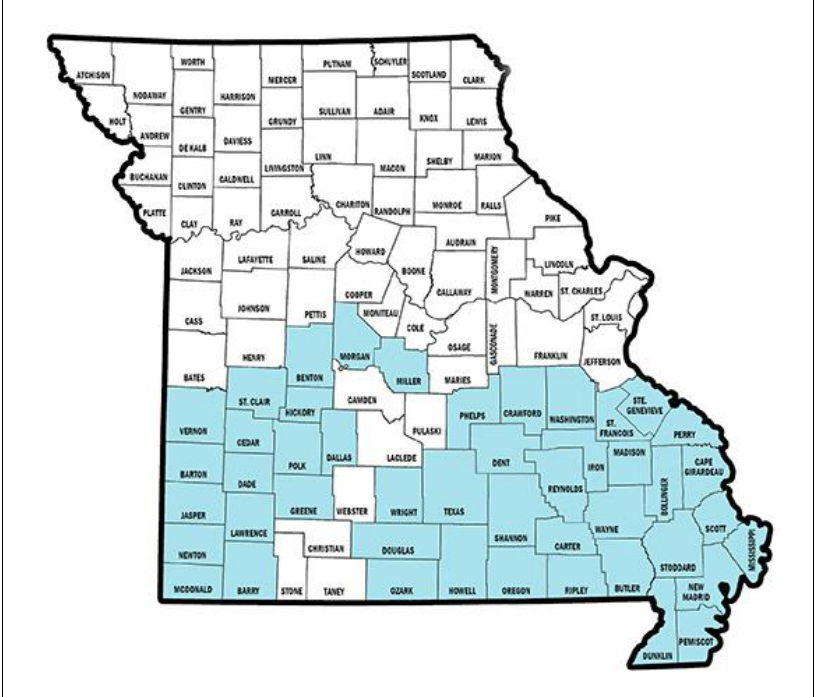
Figure 1. Forty-Six StrikeForce Counties in Southern